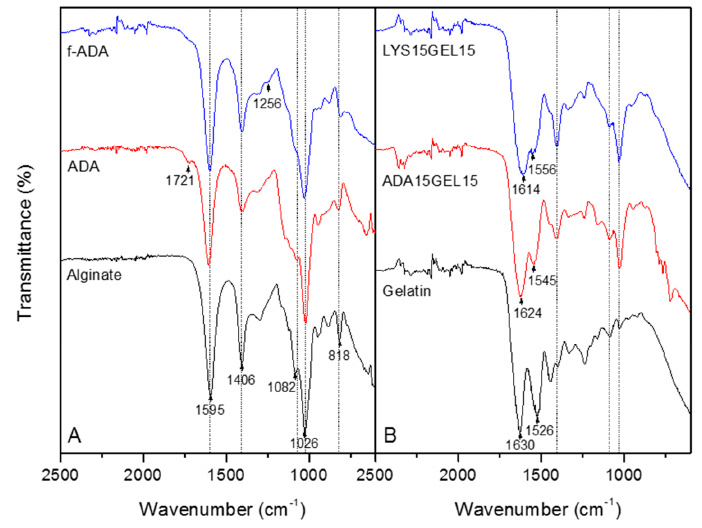
Figure 1. ATR − FTIR spectra of sodium alginate, ADA, and L -lysine − functionalized ADA ( A ) and ADA15GEL15, LYS15GEL15, and gelatin ( B ). The dash represents the alginate’s characteristic absorption peak.